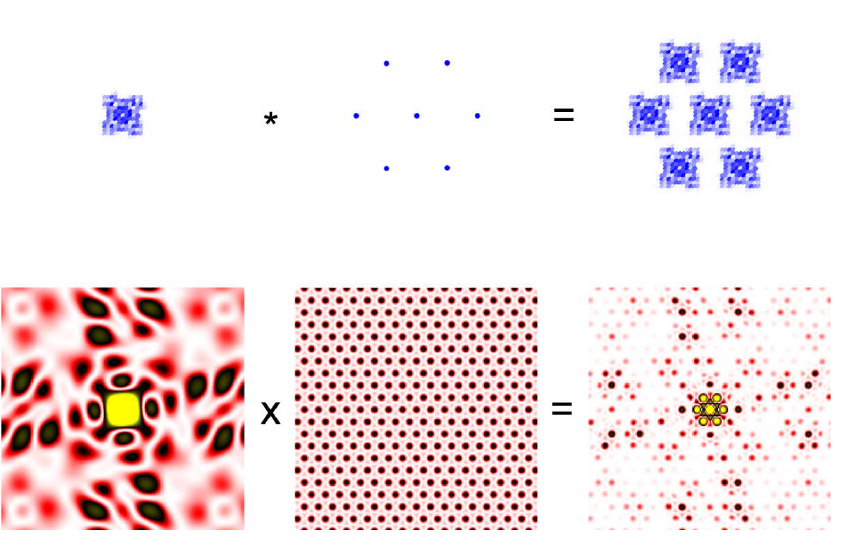
Figure 2. Convolution theorem. A small crystal of protein molecules in which the molecules are arranged in a hexagonal lattice ( Top right ) is the convolution of two functions. The function defining the electron density of each molecule ( Top left ) and the function defining the hexagonal lattice ( Top middle ). The asterisk represents the operation of convolution. The bottom row represents the diffraction pattern (Fourier transform) of the functions in the top row. The diffraction pattern from the protein crystal is the product of the pattern from a single molecule from the lattice. The protein is meant to be a ryanodine receptor.